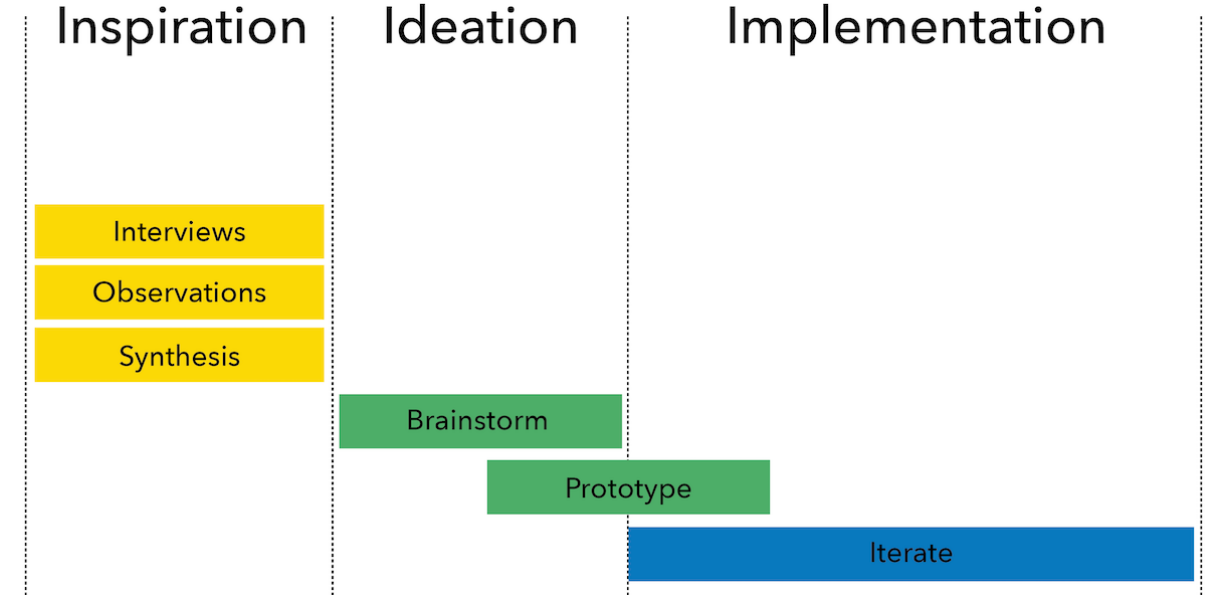
Figure 1. Human-Centered Design